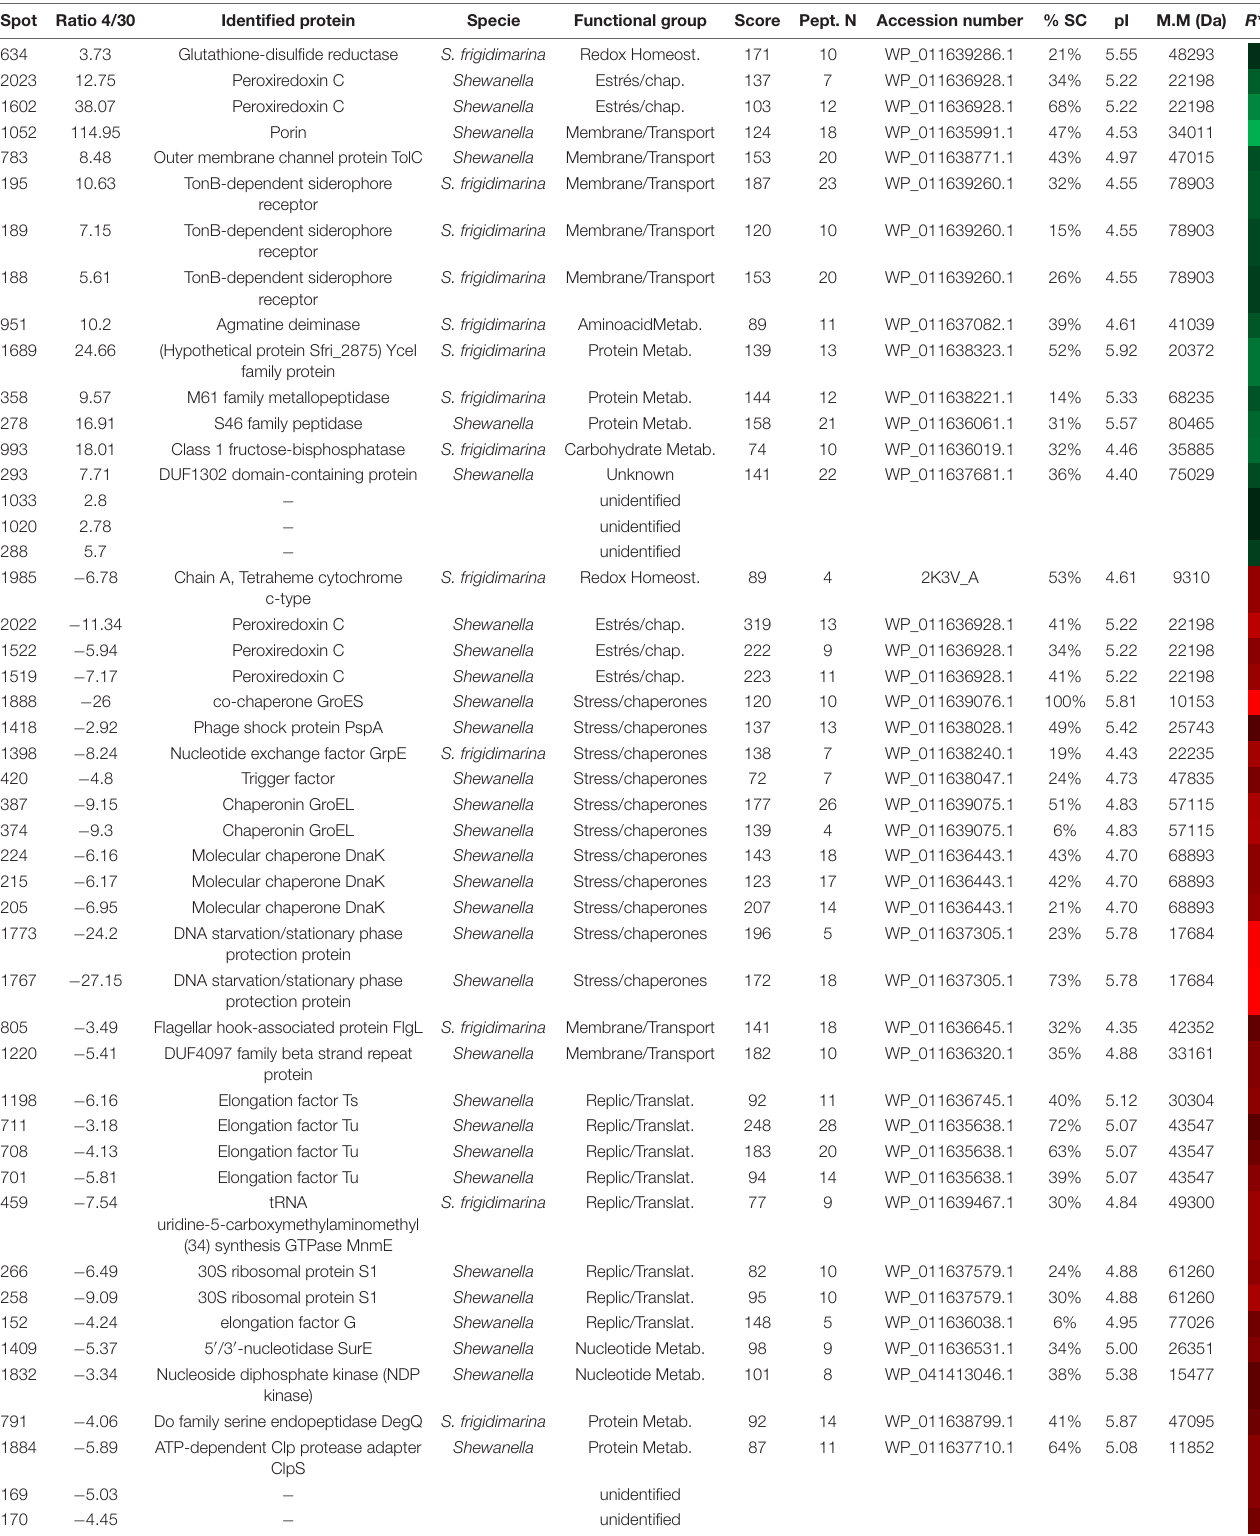
R* represents a heatmap of the ratio 4/30 as in Figure 3 . A specie column refers to the organisms (specie or genus) in which protein has been identified according to the NCBI database.